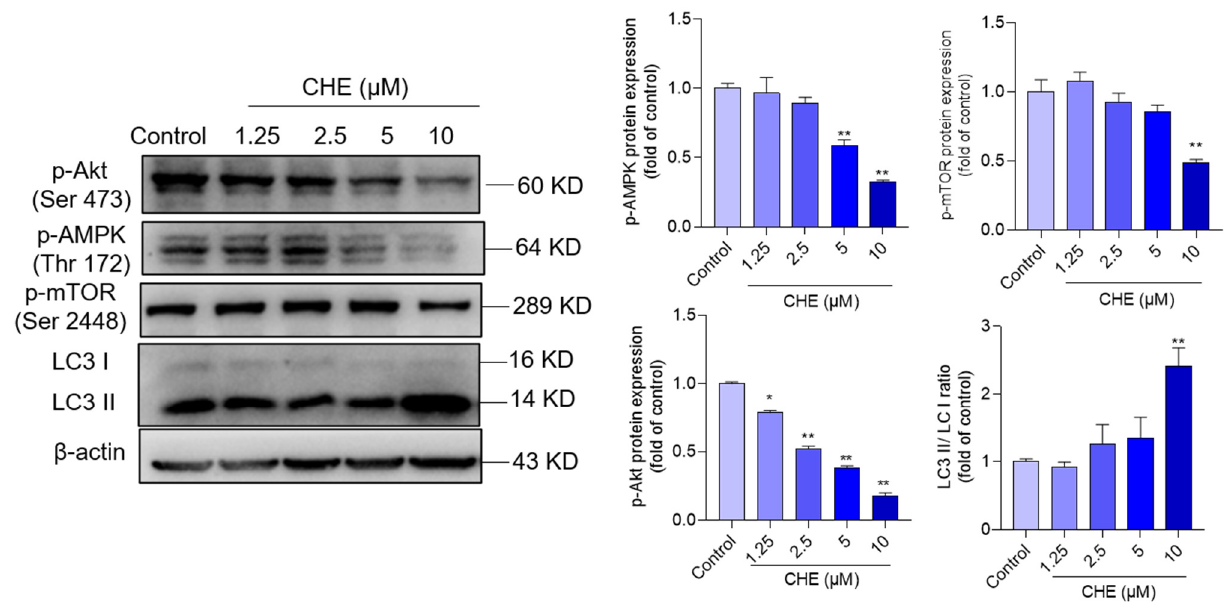
Figure 6. CHE treatment downregulated the expression of p-Akt, p-AMPK, and p-mTOR proteins and upregulated the ratio of LC3II/LC3I in HepG2 cells. The representative images of Western blotting are shown on the left, and the quantified analysis is shown on the right. Data were presented as mean ± S.D. ( n = 3 independent experiments). * p < 0.05 or ** p < 0.01, compared to those in the vehicle control group.